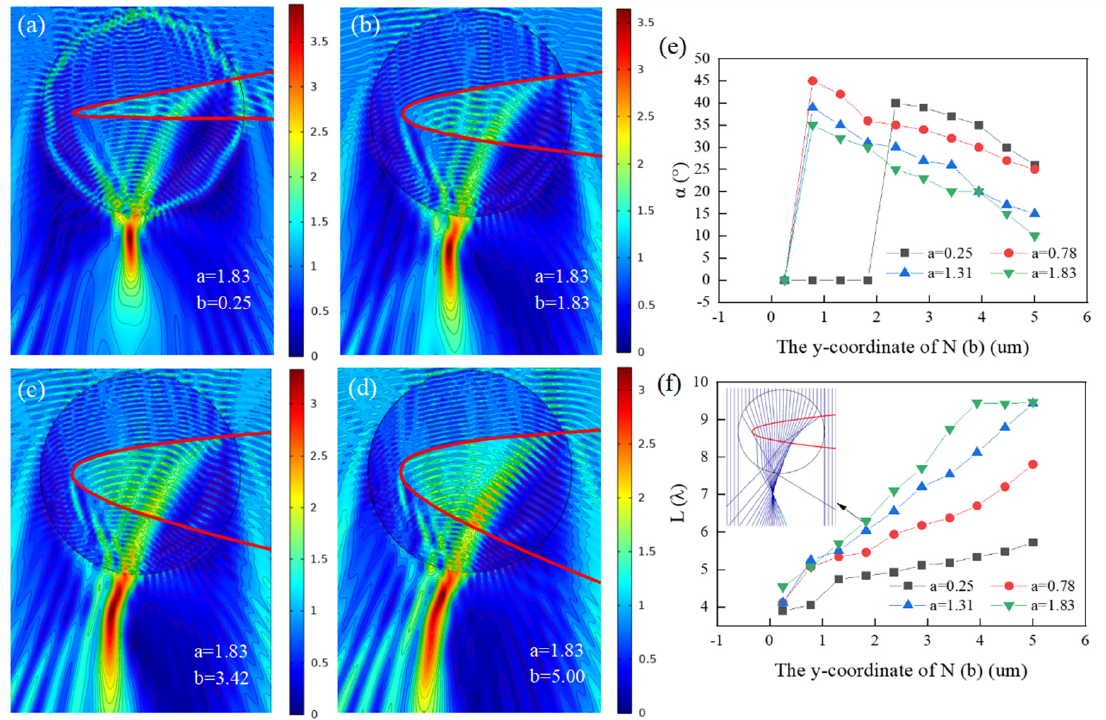
Figure 4. Distribution of electric field under plane wave illumination and the structural property parameters of PH. ( a – d ) P ( − 9,0) and M (0,1.83). ( a ) N (0, − 0.25). ( b ) N (0, − 1.83). ( c ) N (0, − 3.42). ( d ) N (0, − 5.00). ( e ) Relationship between the bending angle of PH and the downward movement of point N from N (0, − 0.25) to N (0, − 5.00) in four cases of M (0,0.25), M (0,0.78), M (0,1.31), and M (0,1.83), respectively. ( f ) Relationship between the effective length ( L ) of PH and the downward movement of point N from the same range as ( e ). Inset: Ray optical model with M (0,1.83) and N (0, − 1.83).